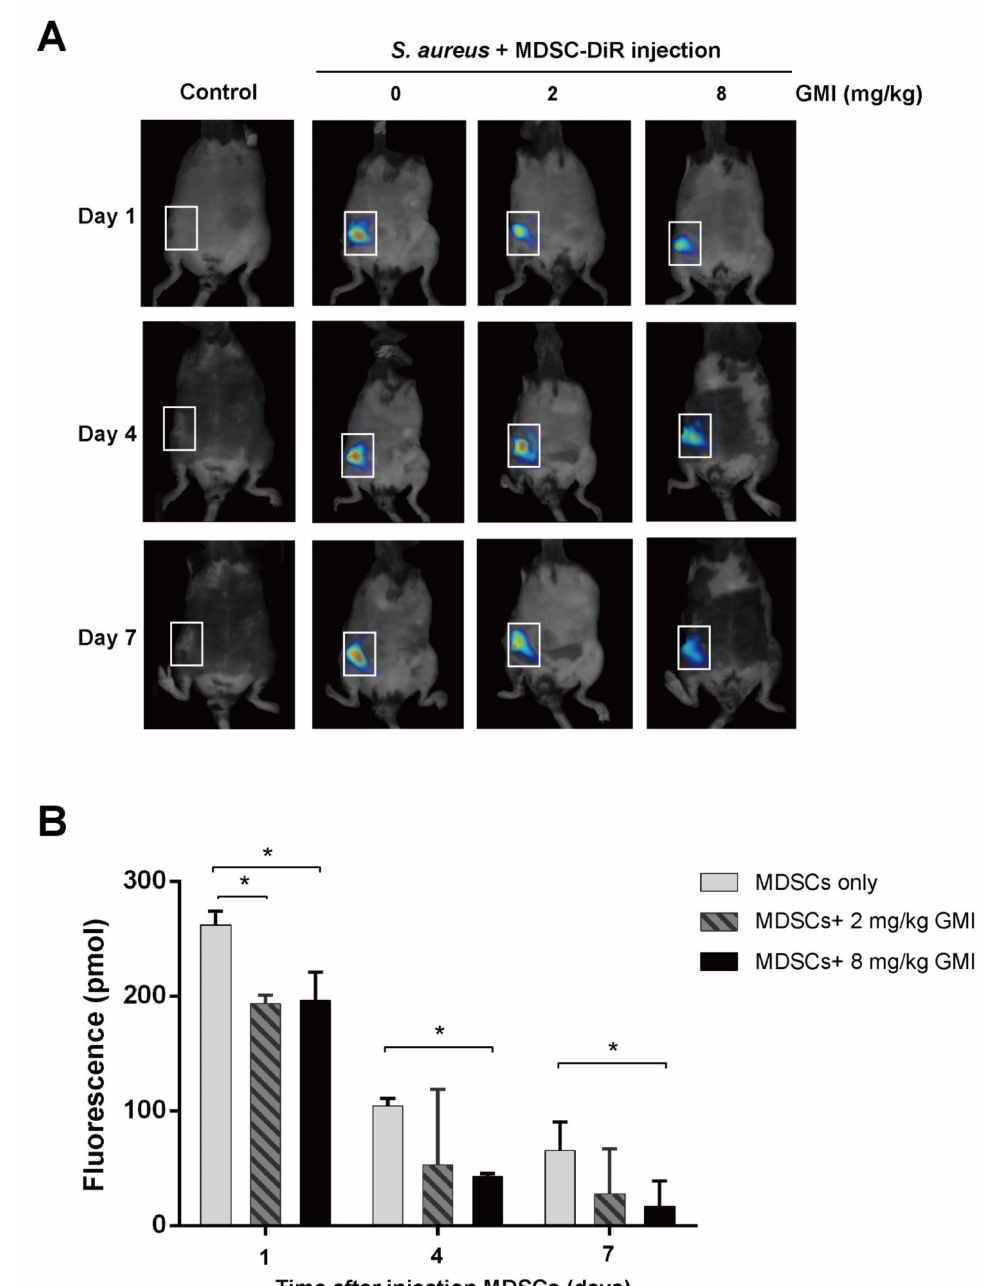
Figure 7. Effects of GMI on the recruitment and accumulation of local MDSCs in the infected regions after S. aureus infection. ( A ) The FMT images obtained on day 1, 4, and 7 after injection. ( B ) Fluorescence of MDSCs were quantitatively assessed with TrueQuan software. The results were analyzed statistically with Student’s t -test. *: p <